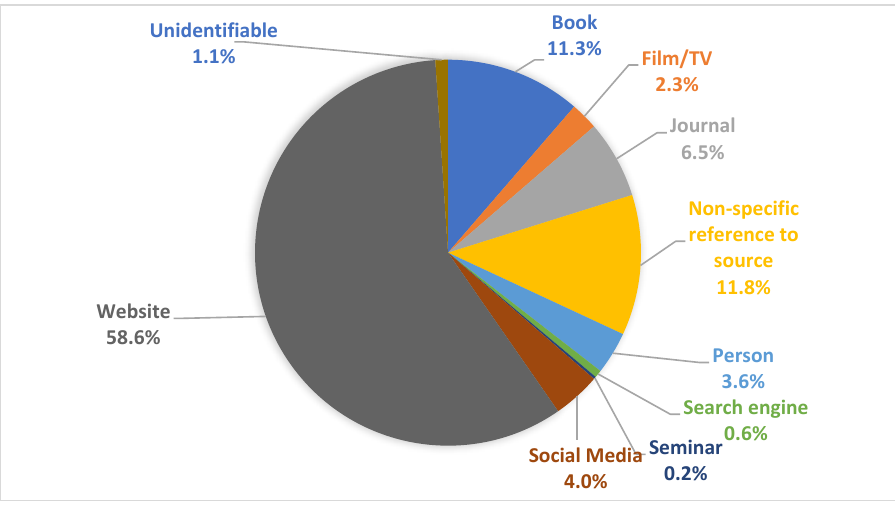
Figure 2. Results of sources of nutrition information.